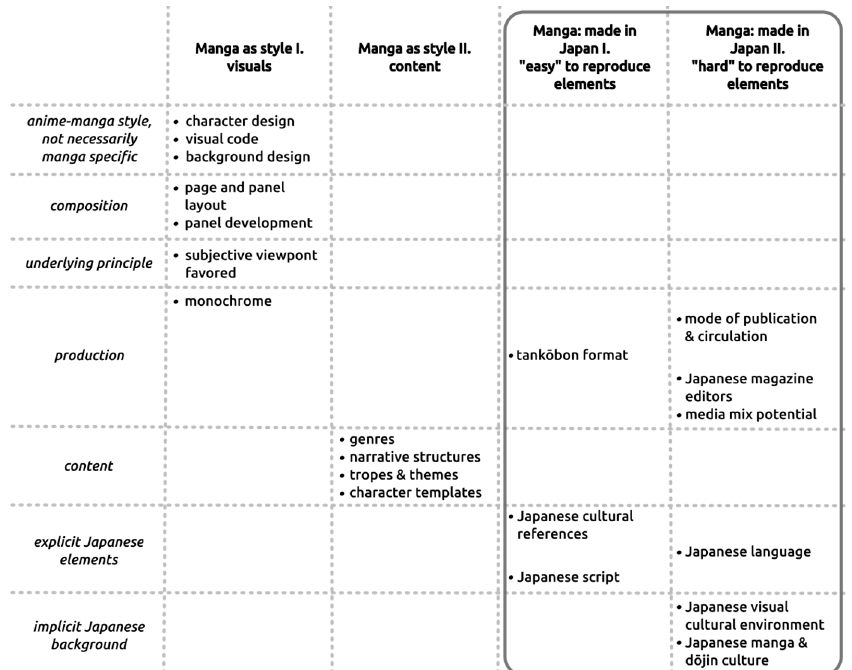
Figure 1. Elements that contribute to making manga what it is.